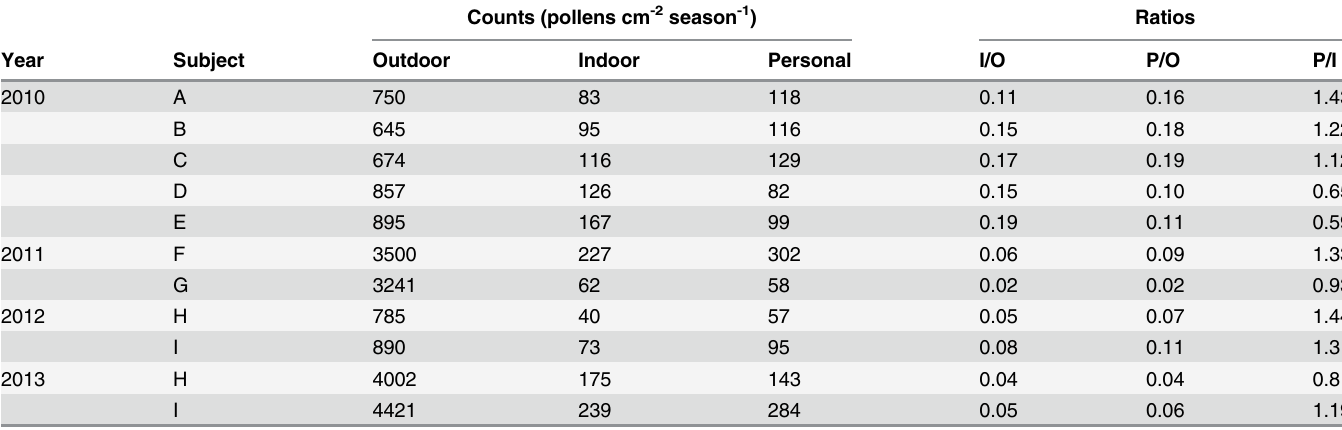
Table 3. Summary statistics of the seasonally-integrated indoor, outdoor, and personal airborne pollen counts measured for each